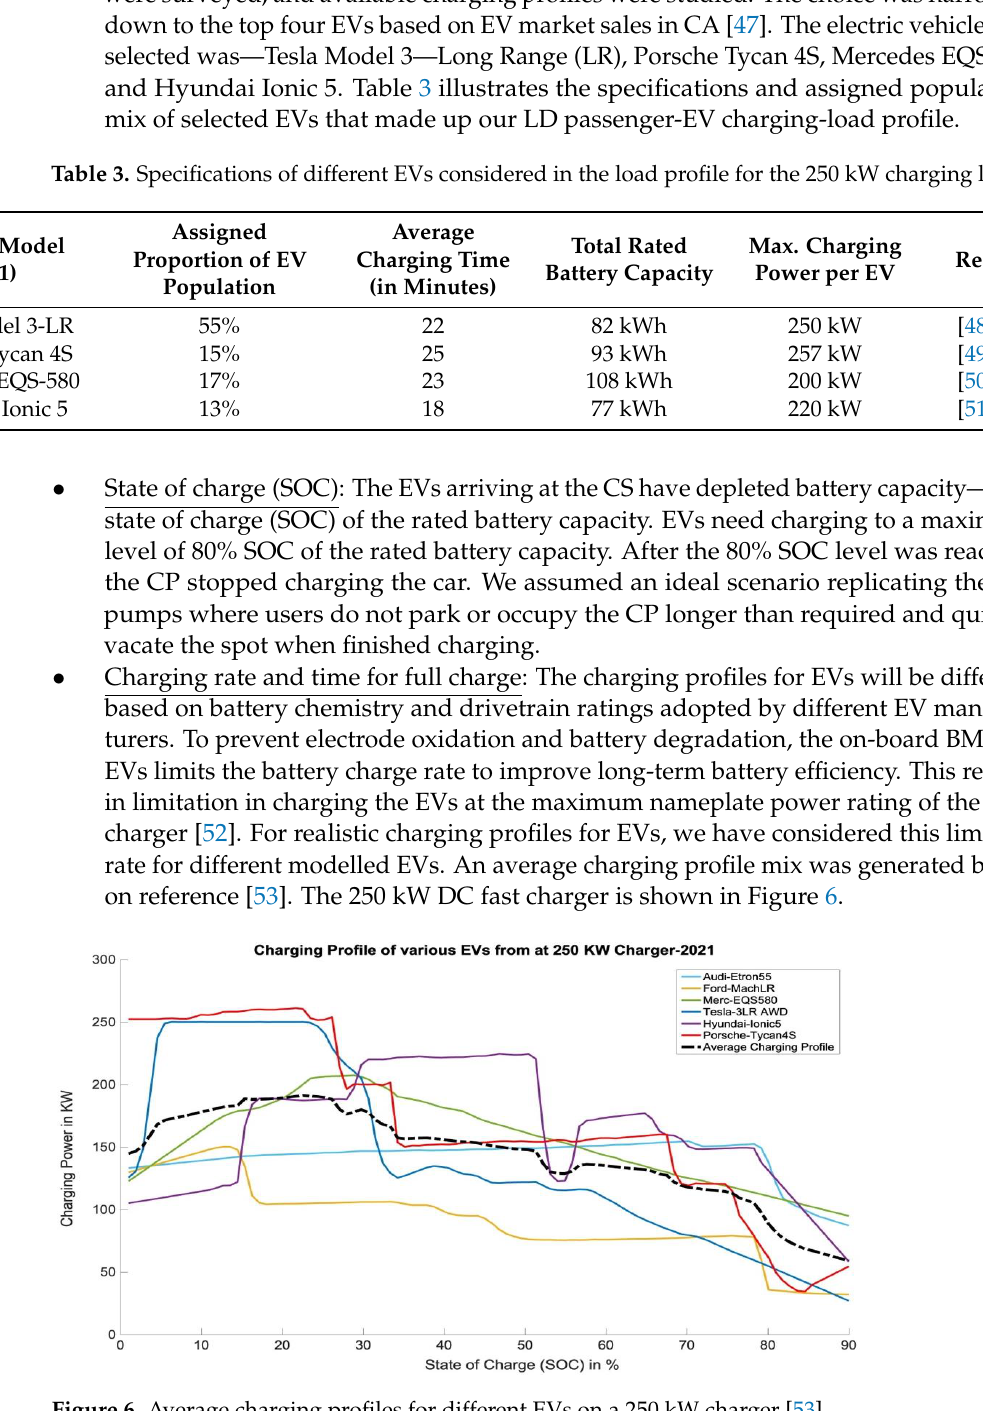
Figure 6. Average charging profiles for different EVs on a 250 kW charger [53].